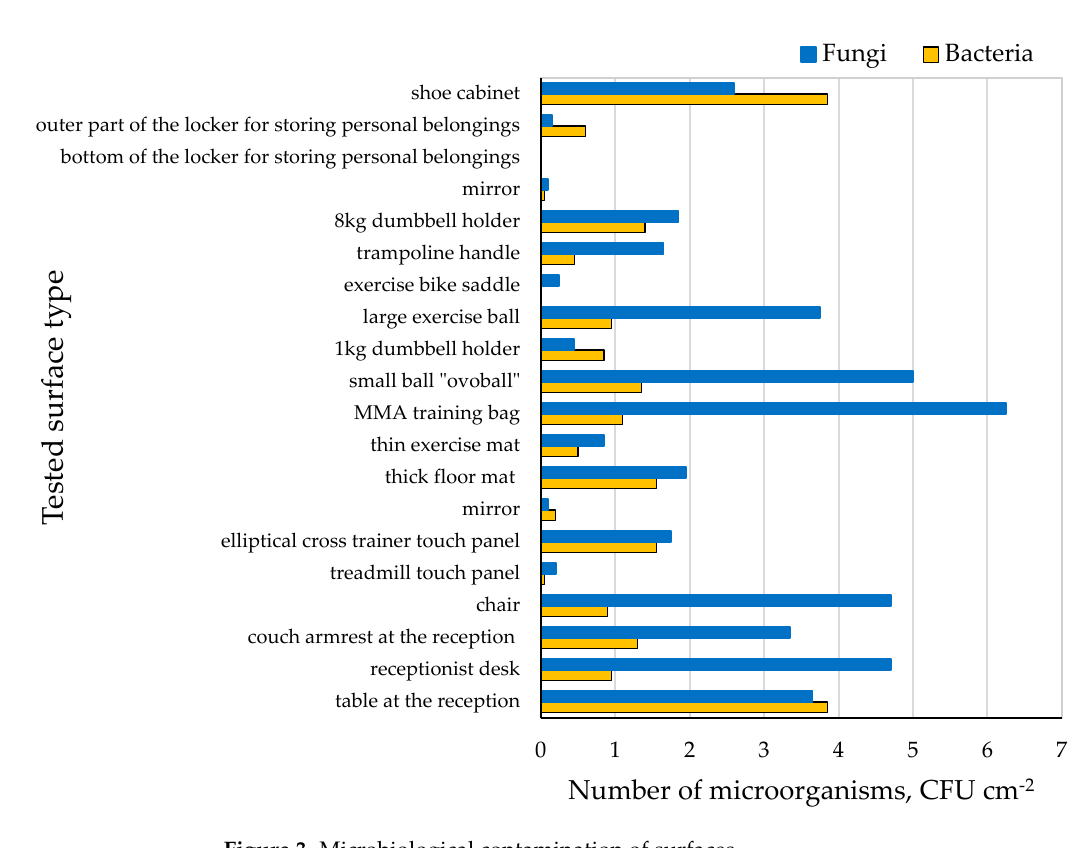
Figure 3. Microbiological contamination of surfaces.